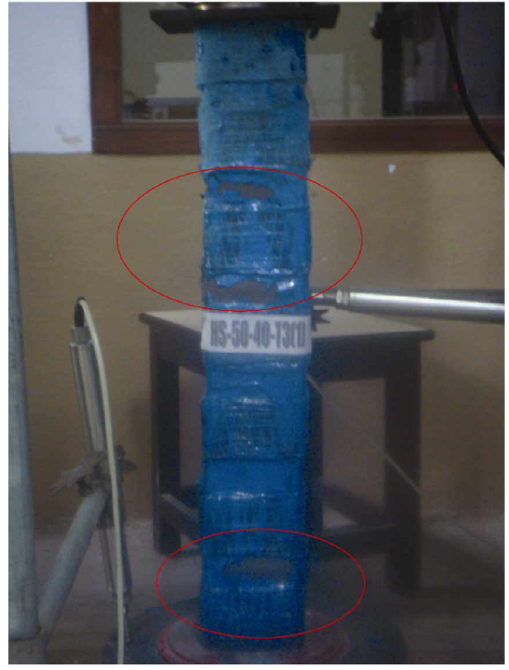
Fig. 10. Failure mode of column HS-50-40-T3(1)